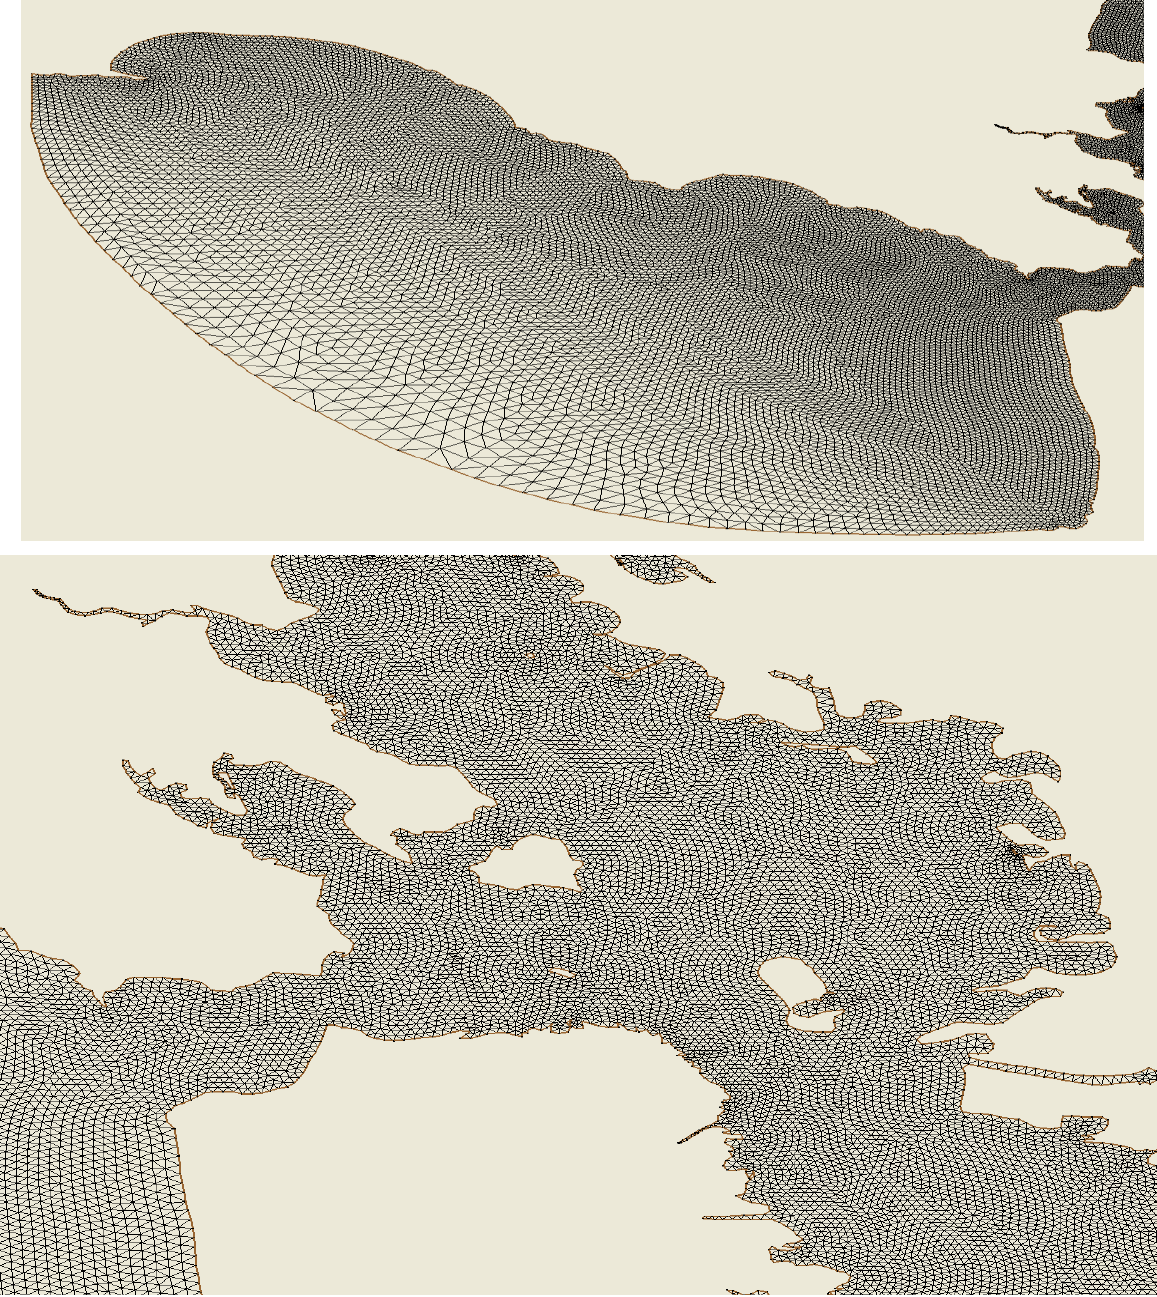
Figure 3. The SFBOFS grid resolution structures are depicted. The element length sizes range from order 400–1700 m along the ocean boundary to order 200 m at the Bay Entrance as shown in the top panel. Within the Bay region the element lengths are reasonably uniform of order 150 m as shown in the lower panel with finer resolution around a few small islands of order 50